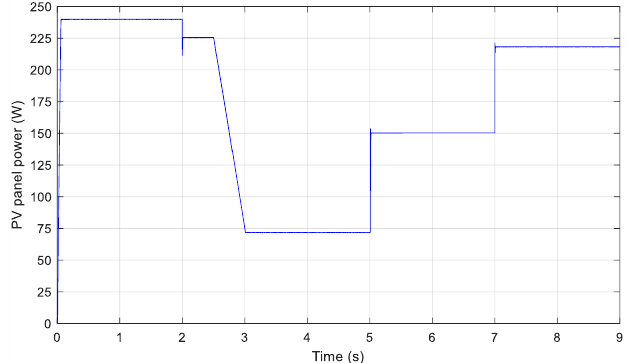
Figure 10. PV panel power.